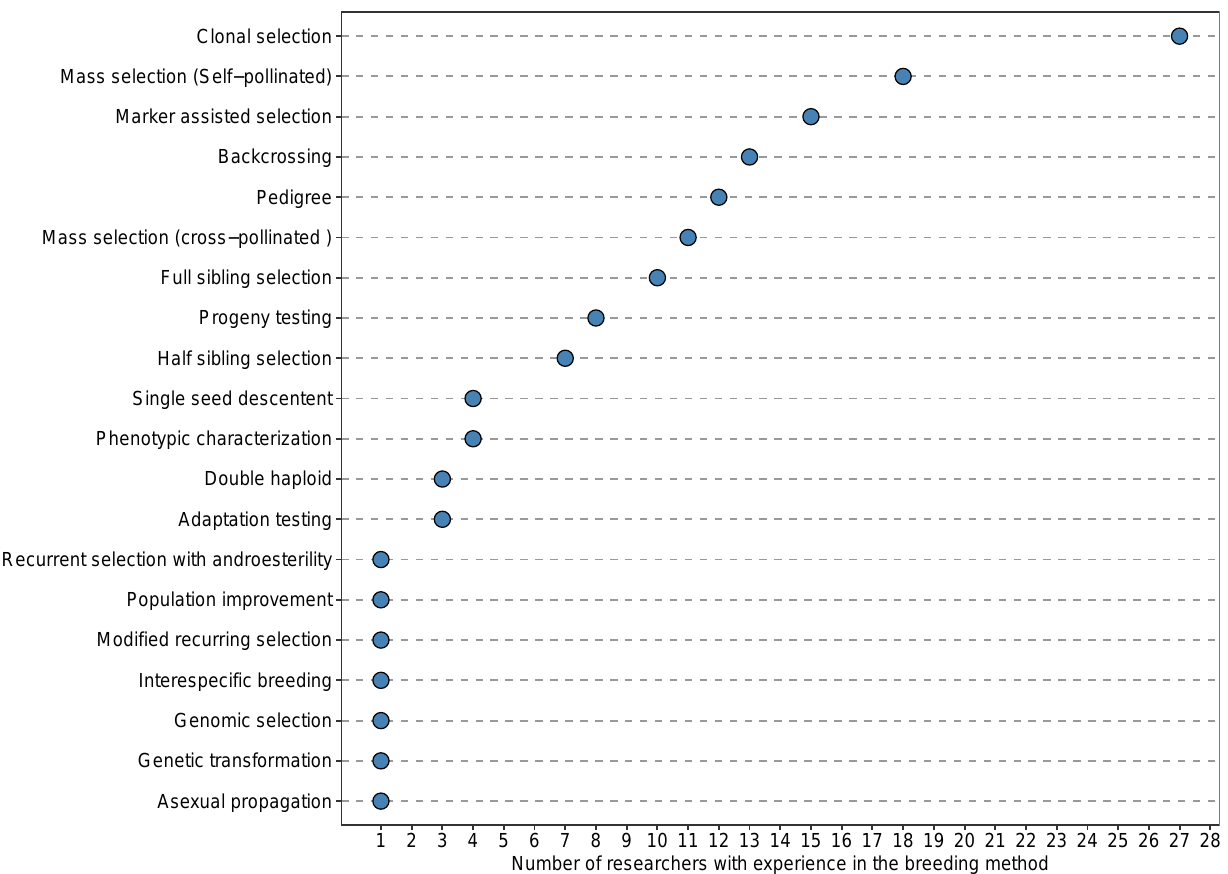
Figure 3. List of plant breeding methods used by researchers at A GROSAVIA in the last ten years sorted by the number of researchers (blue dots) with experience in each breeding method, from the highest to the